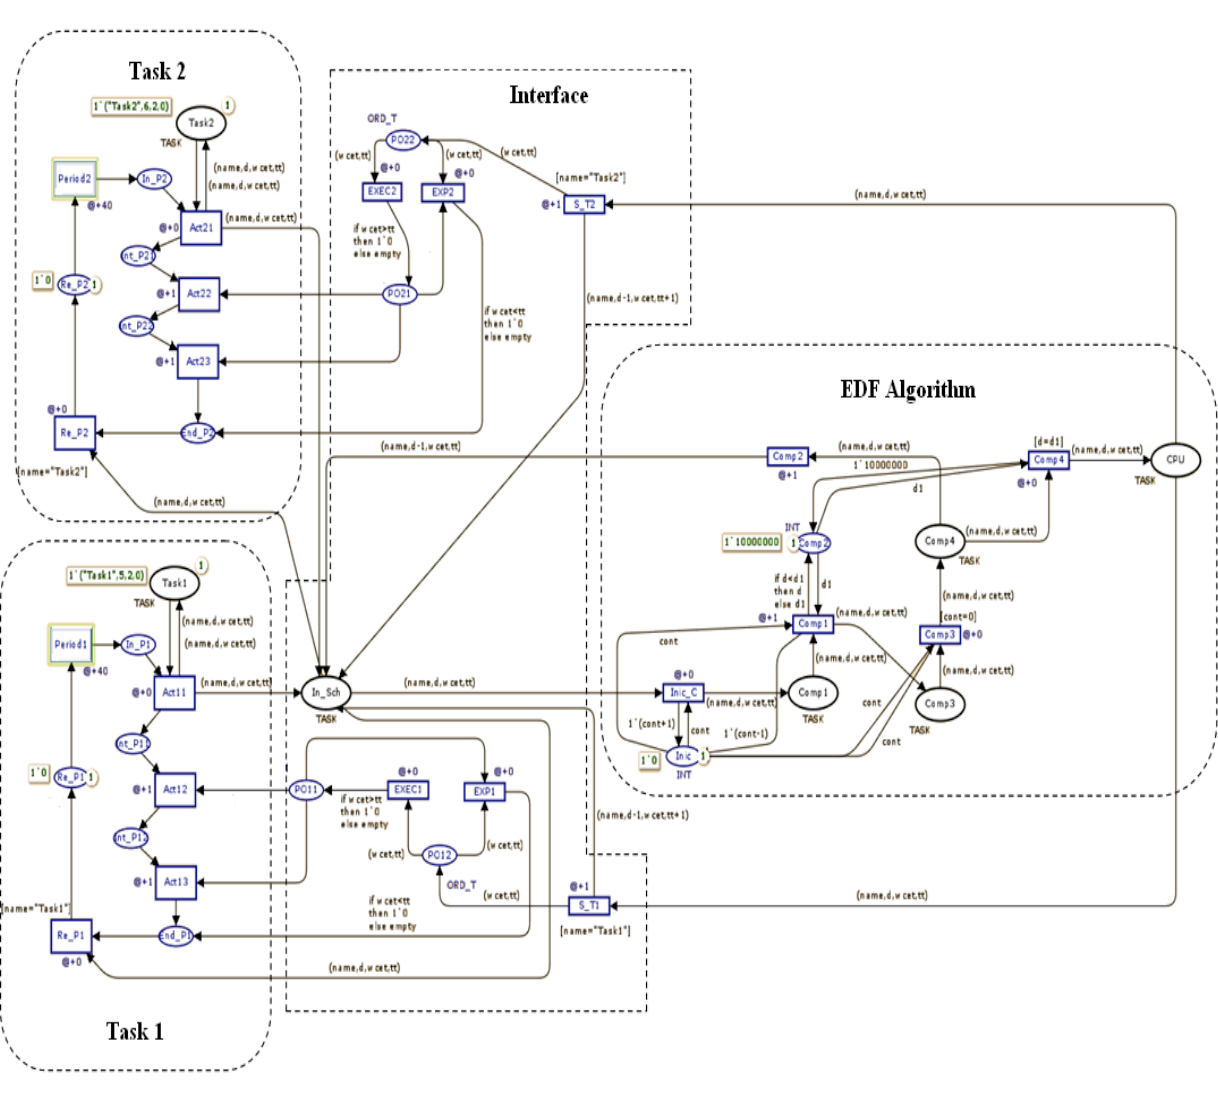
Figure 5. Representation in CPN of a node with two periodic tasks and an EDF